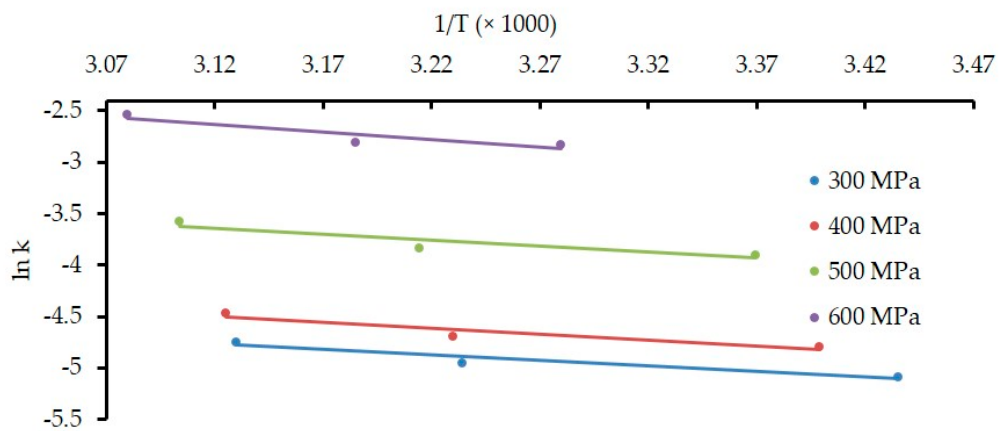
Figure 4. Effect of HPP on the rate of constant ( k ) for denaturation of α -Lac. Temperature at all HPP conditions ( T eff ) is presented in Table 1.